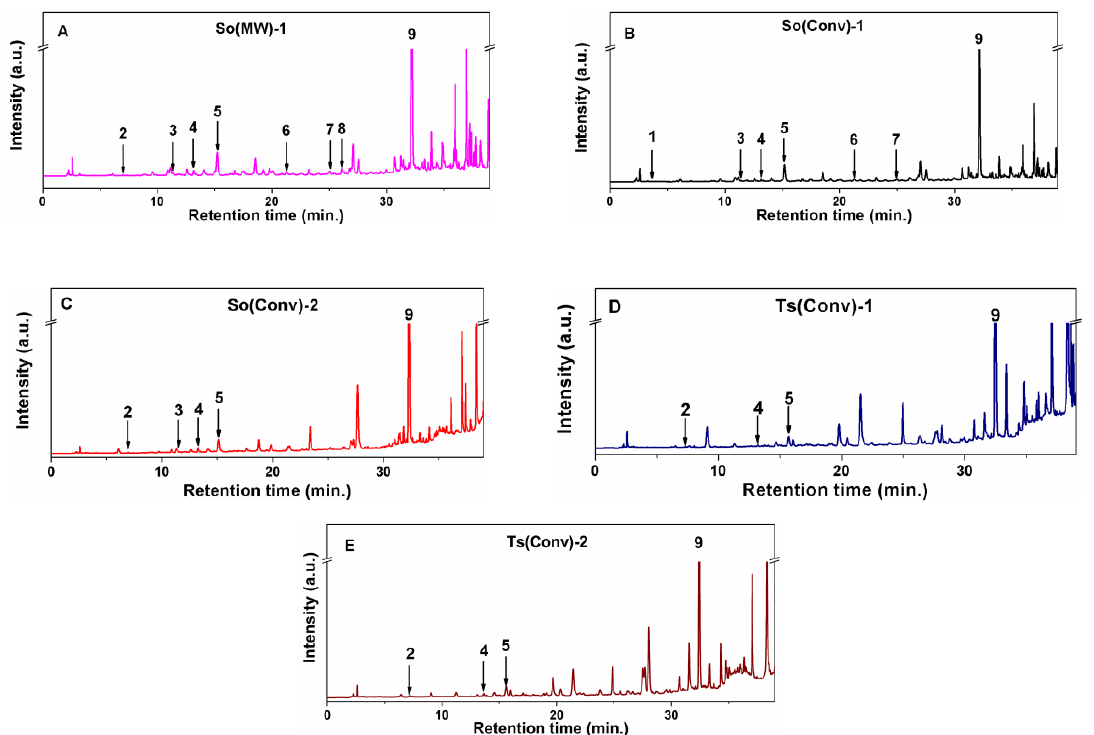
Figure 2. HPLC-PDA chromatogram for ( A ) So(MW)-1, ( B ) So(Conv)-1, ( C ) So(Conv-2), ( D ) Ts(Conv)-1, and ( E ) Ts(Conv)-2 extracts ( 1 —gallic acid; 2 —protocatechuic acid; 3 —caftaric acid; 4 —chlorogenic; 5 —ca ff eic acid; 6 — trans–p –coumaric acid; 7 — trans –ferulic acid; 8 —rutin hydrate; 9 —rosmarinic